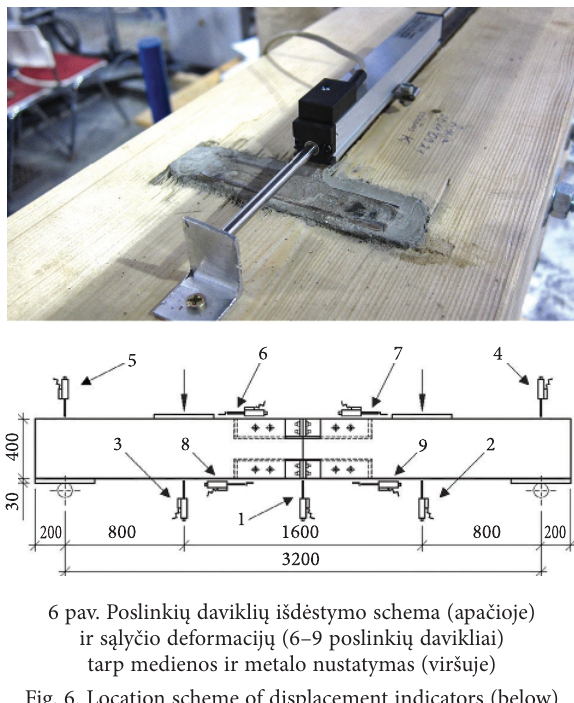
Fig. 6. Location scheme of displacement indicators (below) and contact deformation setting (6–9 displacement indicator) between timber and steel (above)